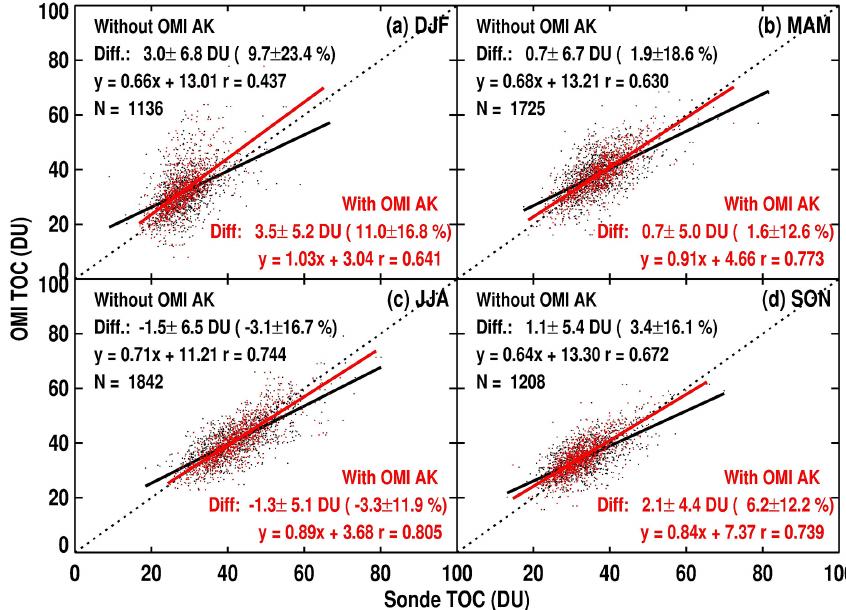
Figure 11. Similar to Fig. 9 but for different seasons at northern middle latitude during the 2004–2014